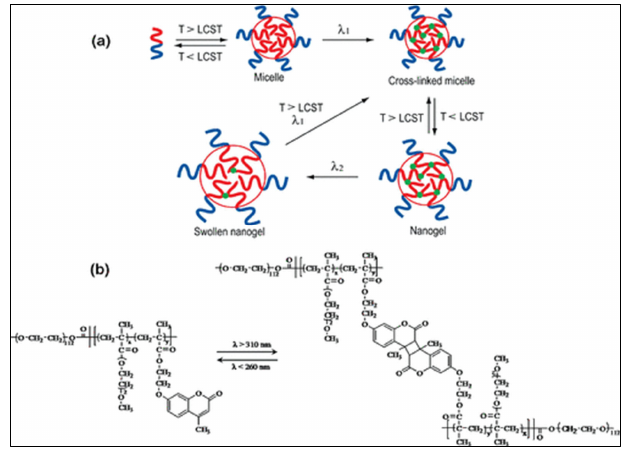
Figure 9. ( a ) Preparation of nanogel particles through micelle formation at T > LCST, followed by crosslinking of coumarin by UV irradiation at λ 1 > 310 nm. De ‐ crosslinking was achieved by irradi ‐ ation at λ 2 < 260 nm; ( b ) Reversible photo ‐ crosslinking of di ‐ block copolymer PEO ‐ b ‐ P(MEOMA ‐ co ‐ CMA). Reprinted with permission from [43]. Copyright 2009 American Chemical Society. Lu et al. [44] synthesized microgels named [poly(MEO 2 MA ‐ co ‐ MAA ‐ co ‐ CMA)] com ‐ posed of 2 ‐ (2 ‐ methoxyethoxy)ethyl methacrylate (MEO 2 MA), methacrylic acid (MAA) and 7 ‐ (2 ‐ mehacryloyloxyethoxy) ‐ 4 ‐ methylcoumarin (CMA). Those microgels were re ‐ sponsive to pH, temperature, and UV irradiation. And similar to He et al. [43], Lu et al., used reversible photo ‐ crosslinking and photo ‐ de ‐ crosslinking by UV irradiation at λ = 365